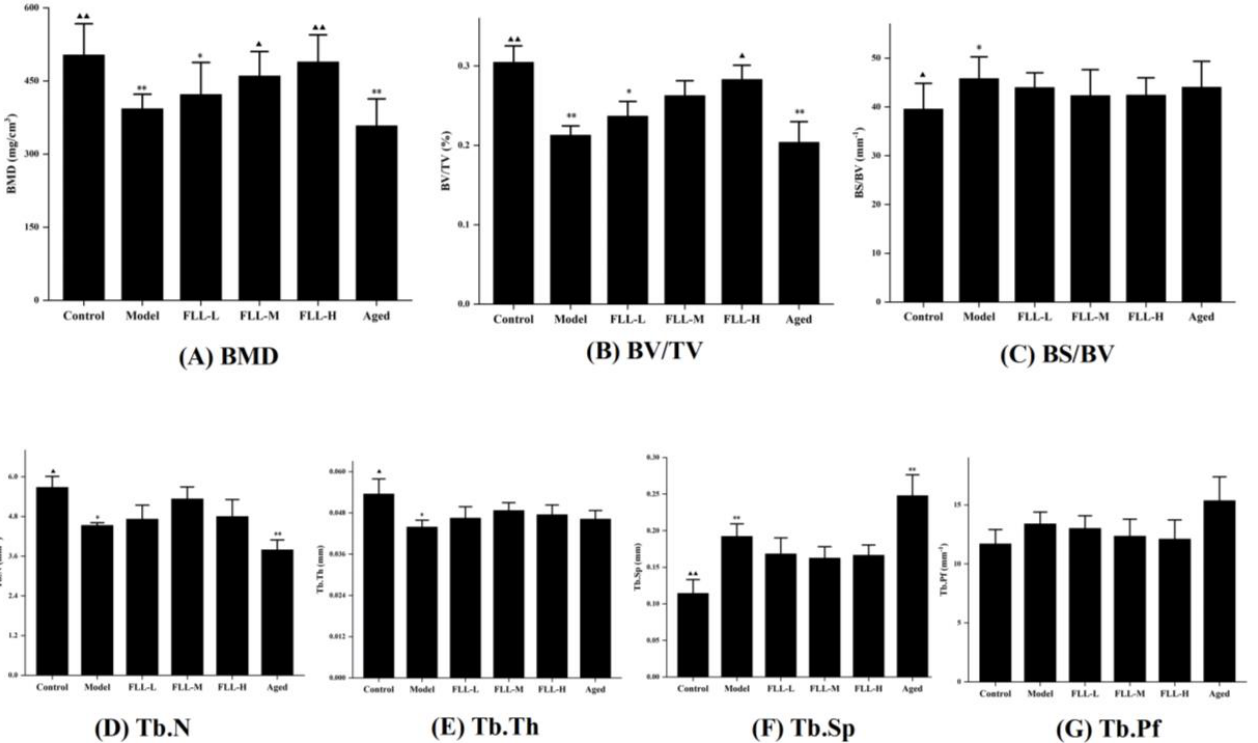
Figure 5. The effects of the FLL on bone trabecular parameters of the femur in osteoporosis mice analyzed by micro-CT. The trabecular analysis includes BMD ( A ), BV/TV ( B ), BS/BV ( C ), Tb.N ( D ), Tb.Th ( E ), Tb.Sp ( F ), and Tb.Pf ( G ). BMD, bone mineral density; BS/BV, specific bone surface; BV/TV, bone volume fraction; Tb.N, trabecular number; Tb.Th, trabecular thickness; Tb.Sp, trabecular separation; Tb.Pf, trabecular bone pattern factor. Data are presented as mean ± SD ( n = 8). Compared with the control group, * p < 0.05 and ** p < 0.01. Compared with the model group, ▲ p < 0.05 and ▲▲ p < 0.01.